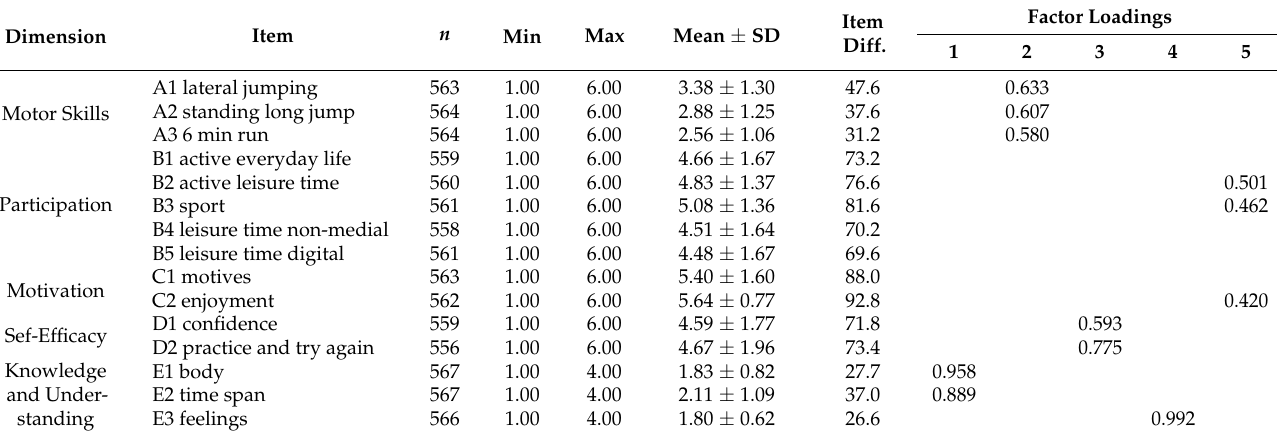
Table A3. Descriptive statistics of the items and exploratory factor